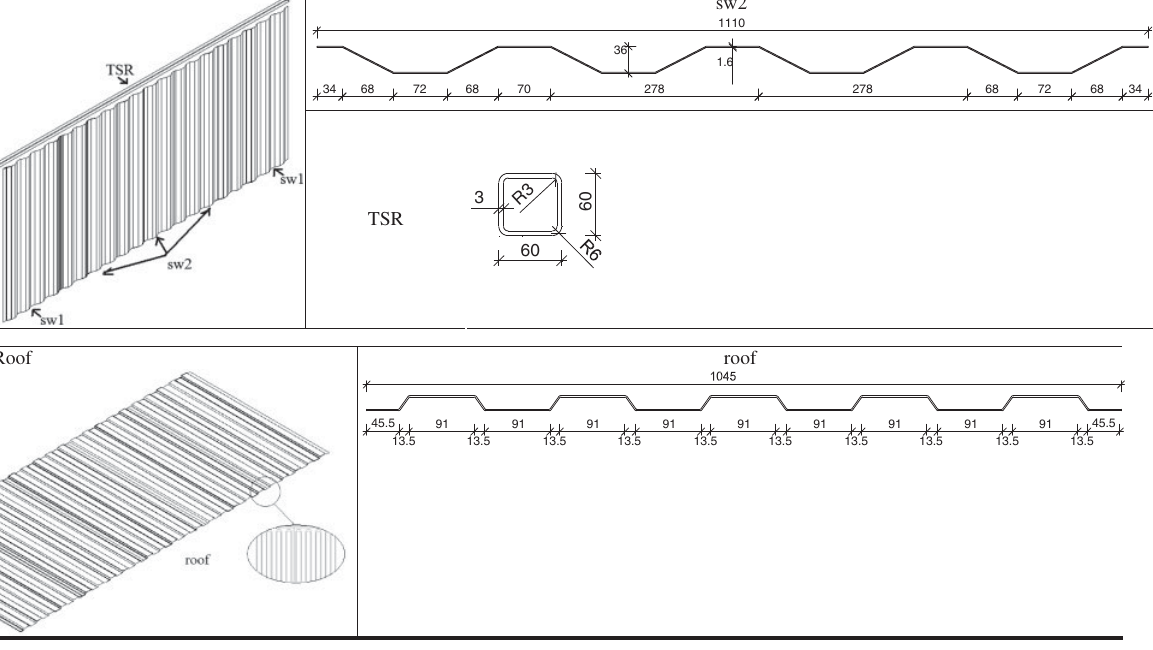
Table 5.2 of Eurocode 3 Part 1-1